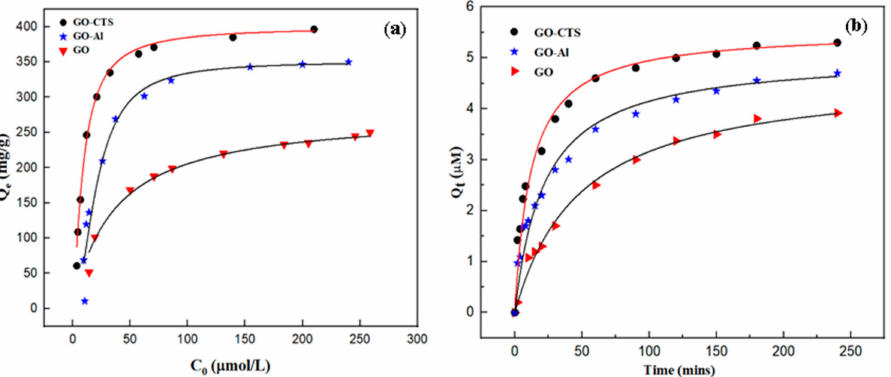
Figure 4. Methylene blue (MB) uptake profiles with GO and GO-based sorbents at pH ~6 and 295 K: ( a ) equilibrium isotherm, and ( b ) kinetic profiles. The fitted lines correspond to the Sips isotherm and pseudo-second-order (PSO) kinetic model, respectively.